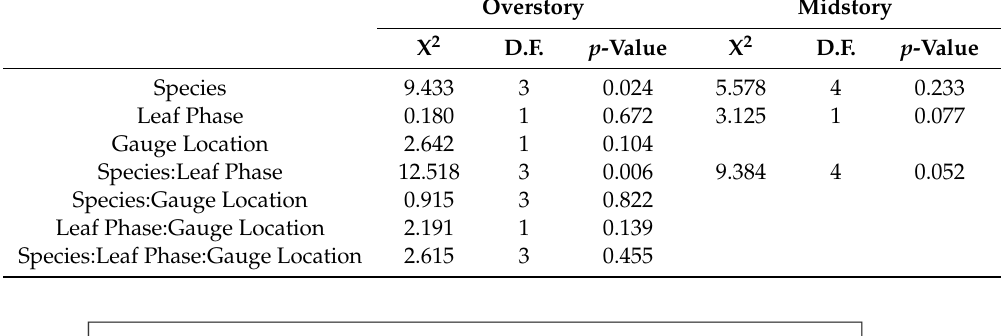
Table 3. Summary of generalized linear mixed model results using standardized z-scores for throughfall. Overstory Midstory